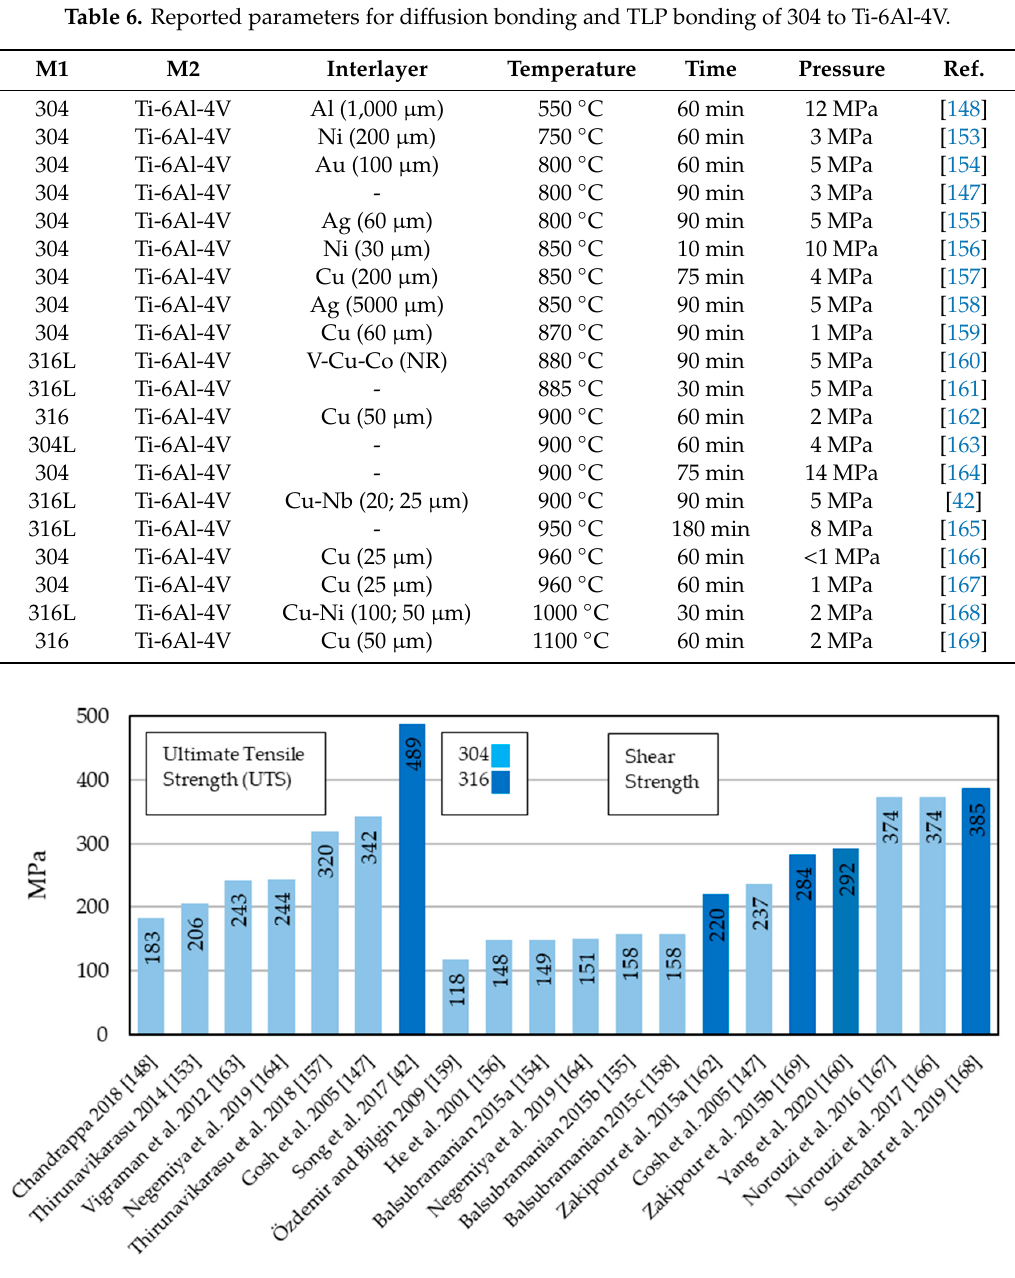
Figure 4. Reported ultimate tensile strength (UTS) (MPa) and shear strength (MPa) of 304 stainless steel and Ti-6Al-4V diffusion bonds and TLP bonds.